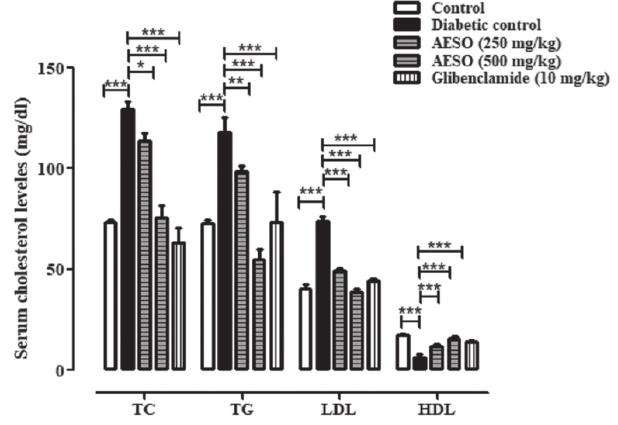
FIGURE 3 - Effect of aqueous extract of Sigesbeckia orientalis on total cholesterol, triglycerides, low density lipoproteins and high density lipoprotein levels in different treatment groups. Comparison was made between lipids levels in serum samples of alloxan-induced diabetic rats and AESO and glibenclamide treated animals Where ns = non-significant, * = p < 0.25, ** = p < 0.01, *** = p < 0.001, TC = Total cholesterol, TG = Triglycerides, LDL = Low density lipoproteins, HDL = High density lipoproteins and Diabetic control = Alloxan-induced diabetic rats (150